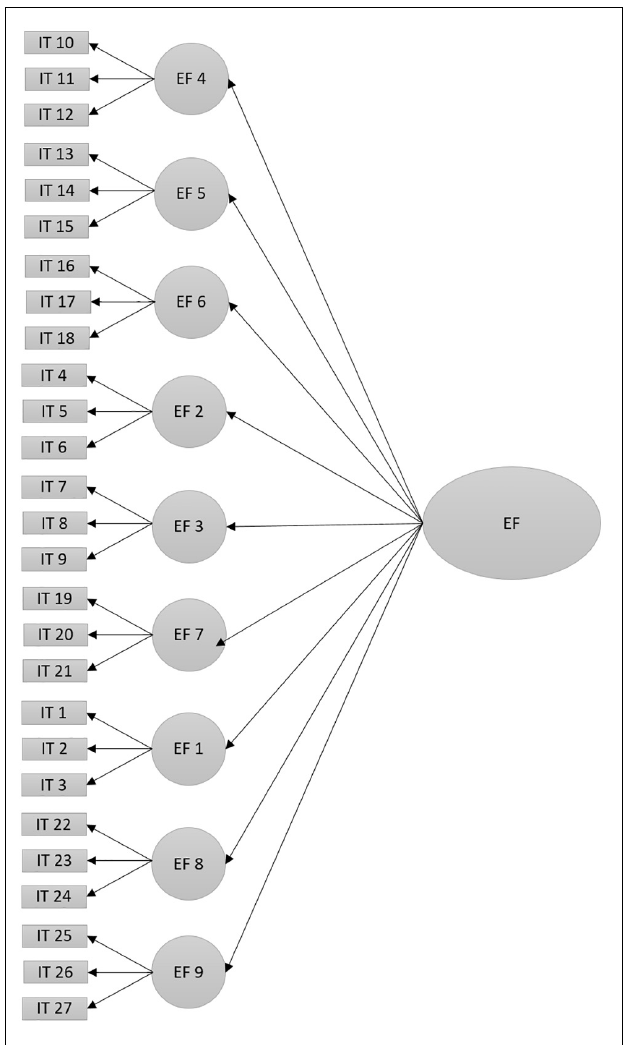
FIGURE 2 | Factorial model of second order with one executive central factor of the scale EOCL-1 (Model 2). Acronyms are the same as in Figure 1 .